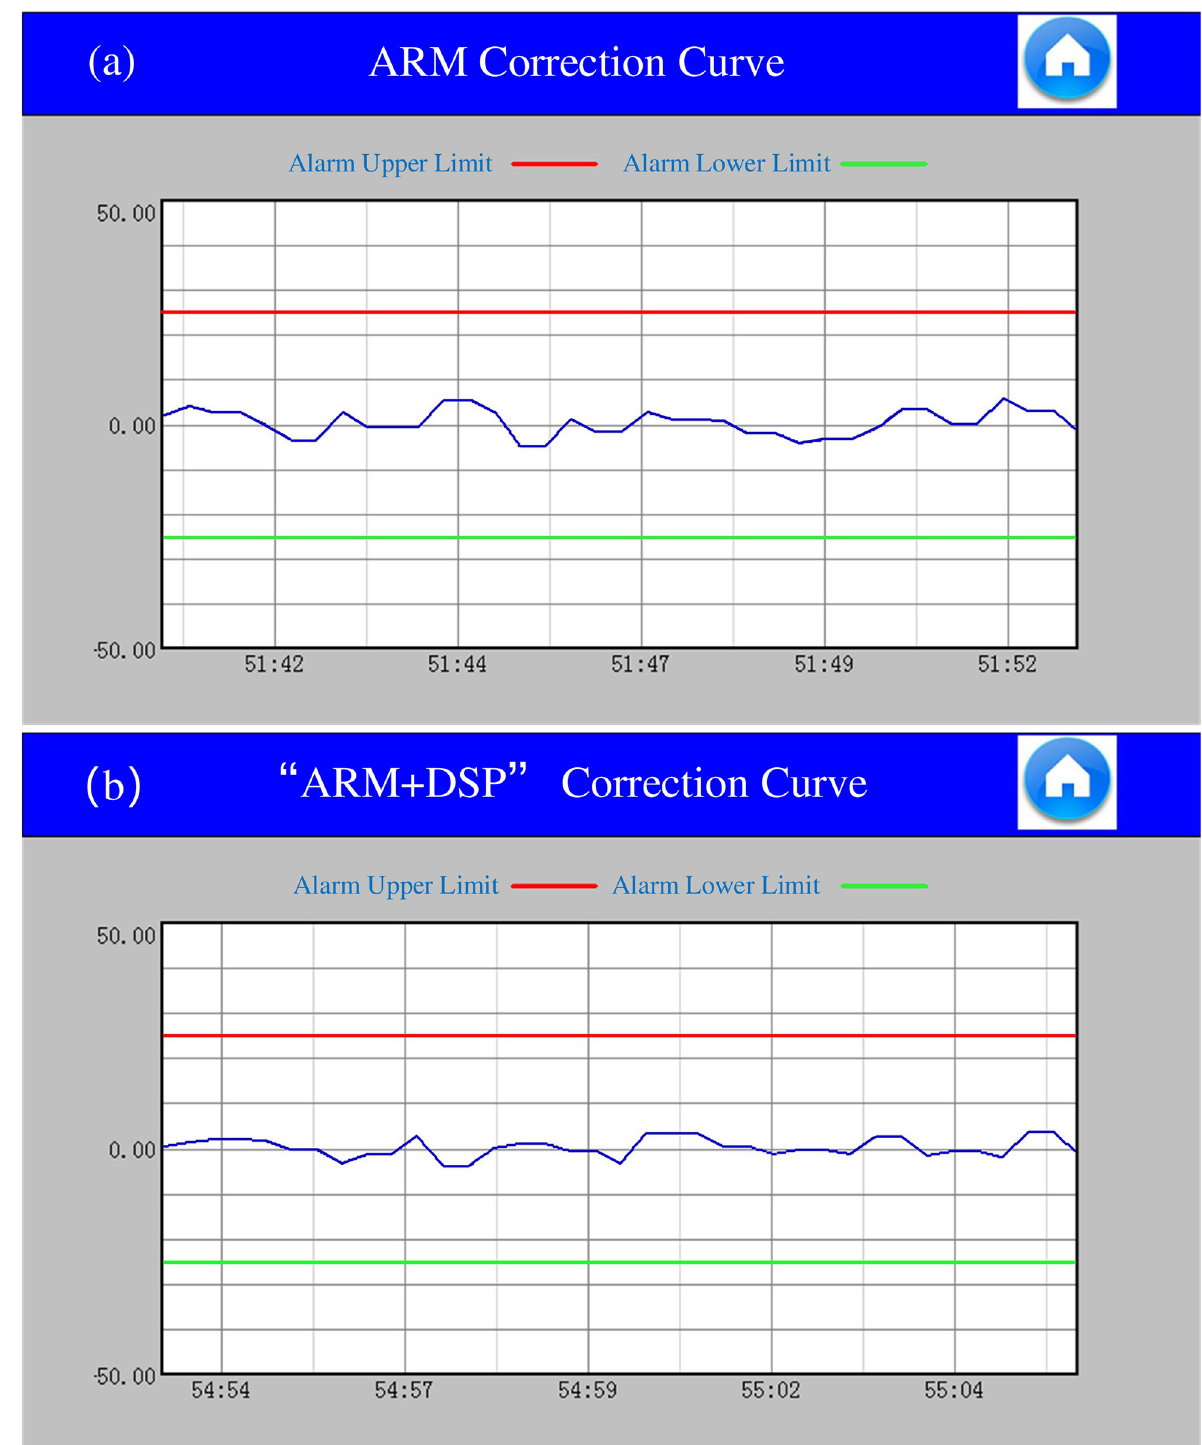
Fig 23. (a) ARM deflection control curve, (b) "ARM+DSP" deflection control curve.